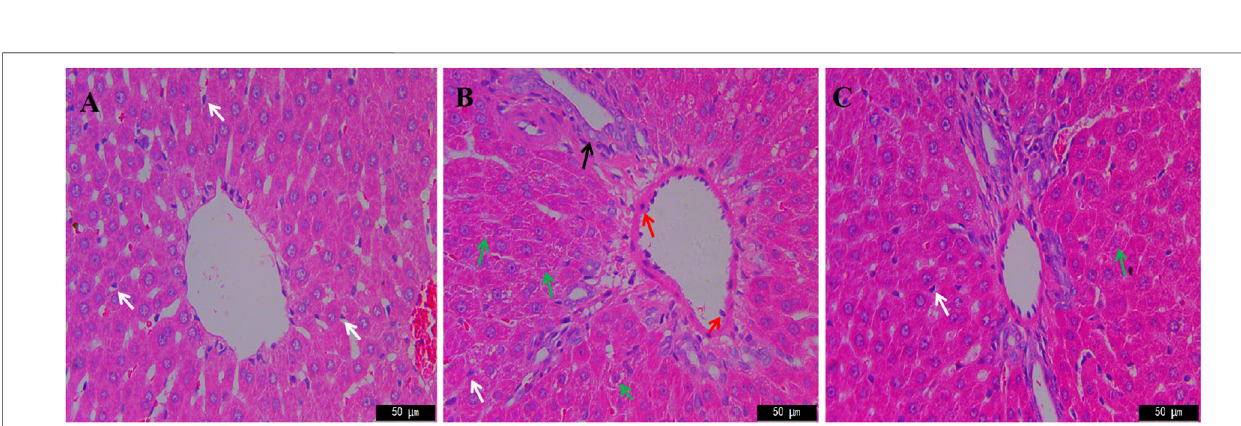
Frontiers in Pharmacology |